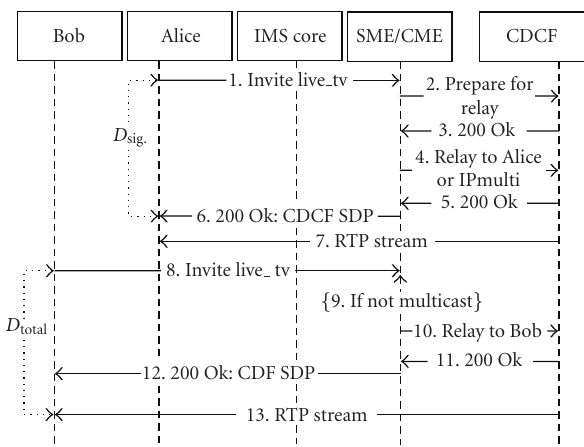
Figure 6: End-to-end messages flow of a live TV session.